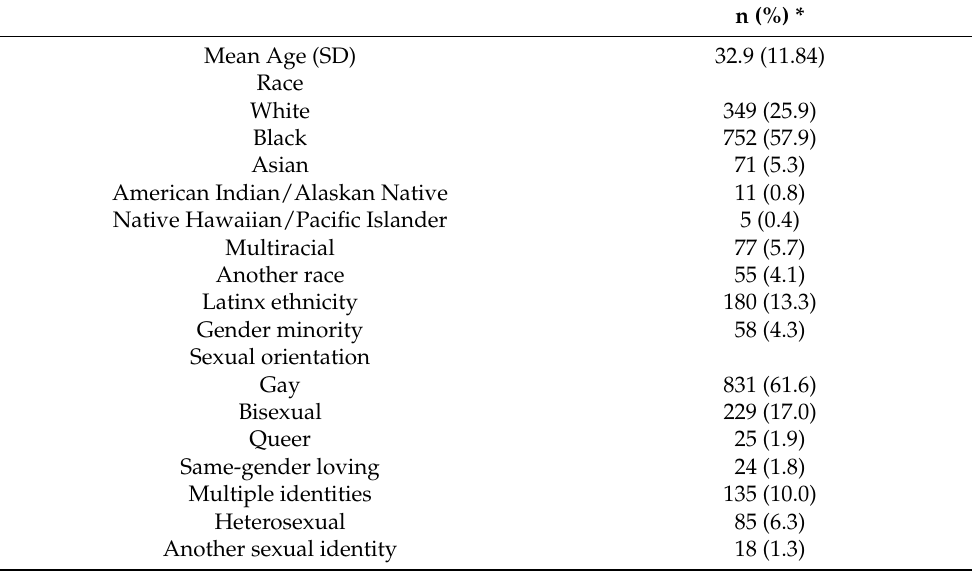
Table 1. Demographics of online sample of sexual and gender minority participants (N =